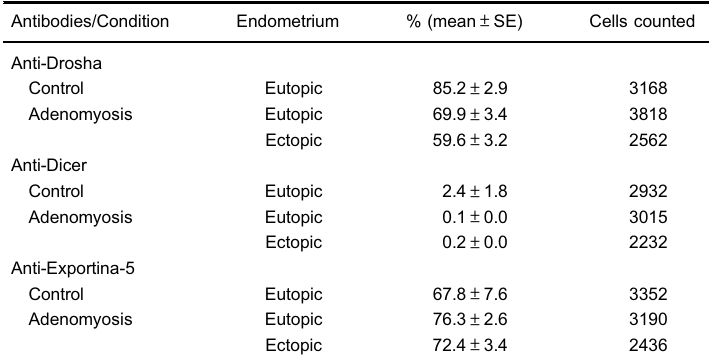
Table 3. Percentage of positive epithelial cells for each antibody in each